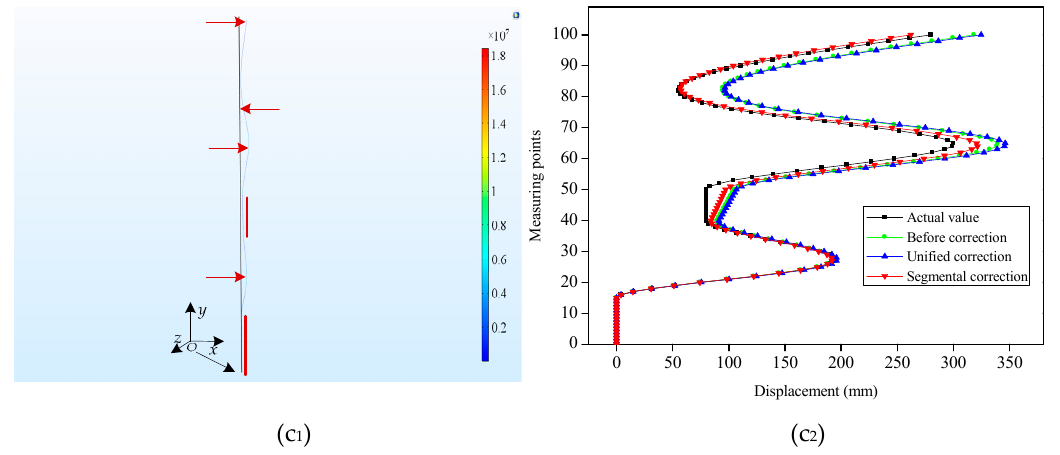
Figure 6. Demonstration of the simulation results of the slender plate model under different loading modes. ( a 1 ), ( b 1 ) and ( c 1 ) represented the simulation diagrams for Type 4, Type 5 and Type 6, respectively; ( a 2 ), ( b 2 ) and ( c 2 ) represented the displacements contrast of the measuring points for Type 4, Type 5 and Type 6, respectively.